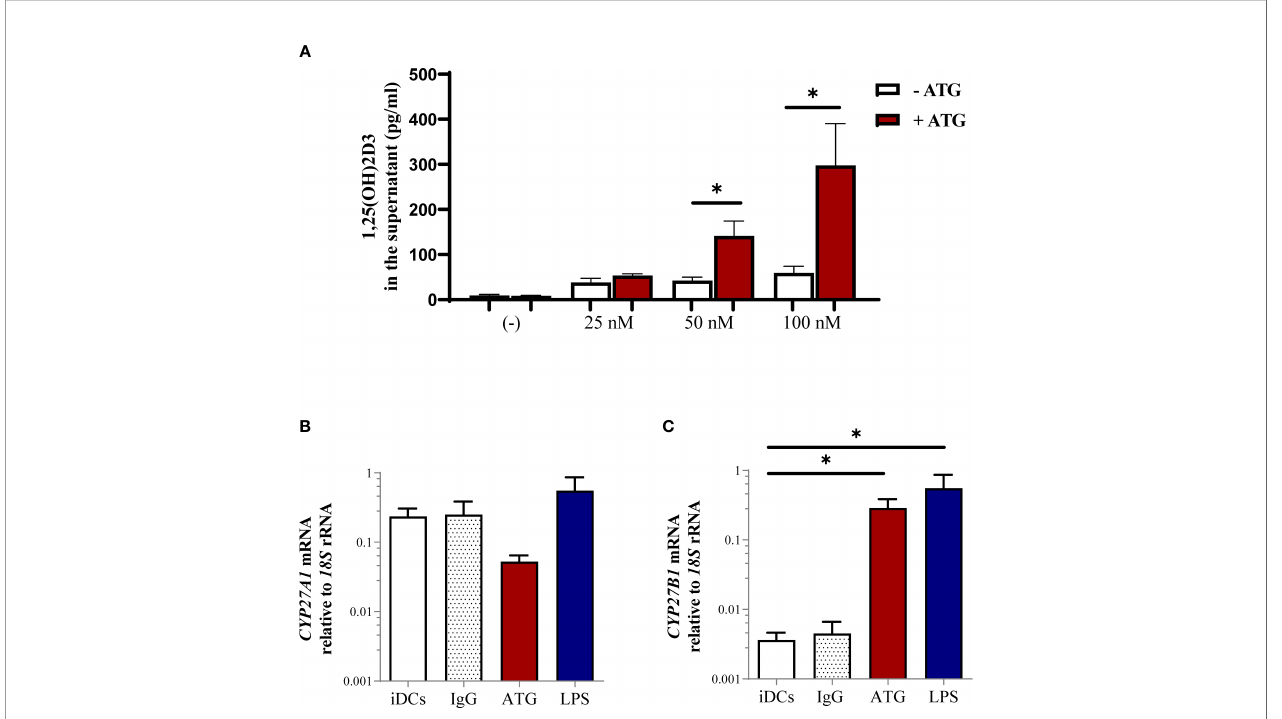
FIGURE 2 | Impact of ATG treatment on production of 1,25(OH)2D3 by human monocyte-derived dendritic cells (DCs). (A) Human monocyte-derived DCs were stimulated for 24 h in the presence of different 25(OH)D3 concentrations in the presence or absence of ATG (100 µg/ml). After 24 h the production of 1,25(OH)2D3 was analyzed by means of chemiluminescence immunoassay. Data are means ± SEM (n ≥ 3). Statistical analysis was performed using Mann-Whitney-U test, two- tailed. Panel (B) depicts CYP27A1 and (C) shows CYP27B1 mRNA expression of DCs analyzed by means of quantitative real-time PCR relative to 18S rRNA expression. Data are means ± SEM (n = 4). Statistical analysis was performed using Kruskal-Wallis and Dunn ’ s posthoc test [*p ≤ 0.05, tested versus immature DC